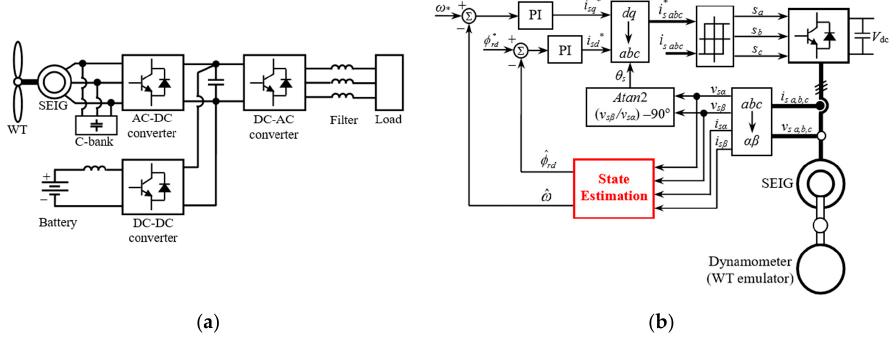
Figure 1. Wind energy conversion system: ( a ) DC-microgrid based standalone self-excited induction generator with battery storage; ( b ) generator side converter control scheme.